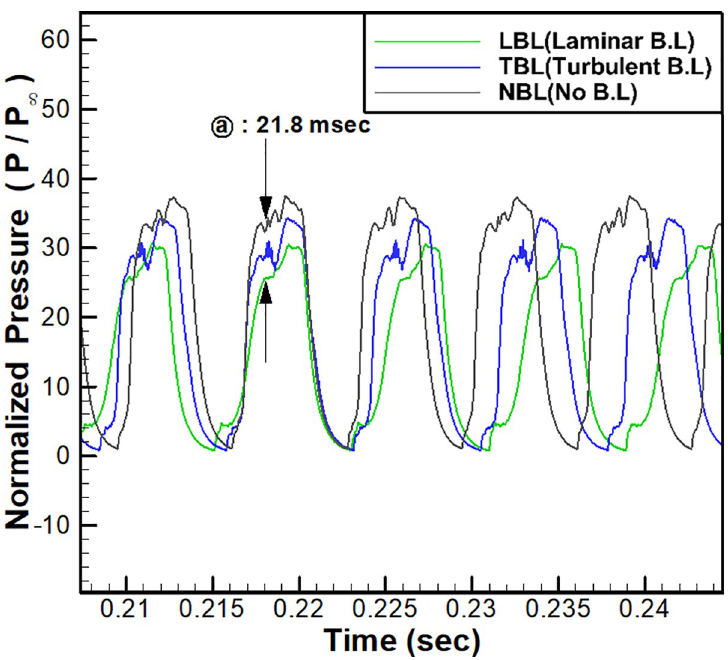
Fig 13. Comparison among the pressure time histories at x/h = 12.21 for the different boundary layer cases.